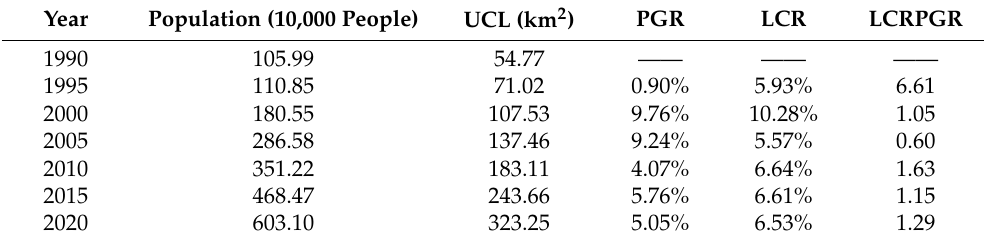
Table A1. Data of population, construction land, and sustainable development in Nanning.